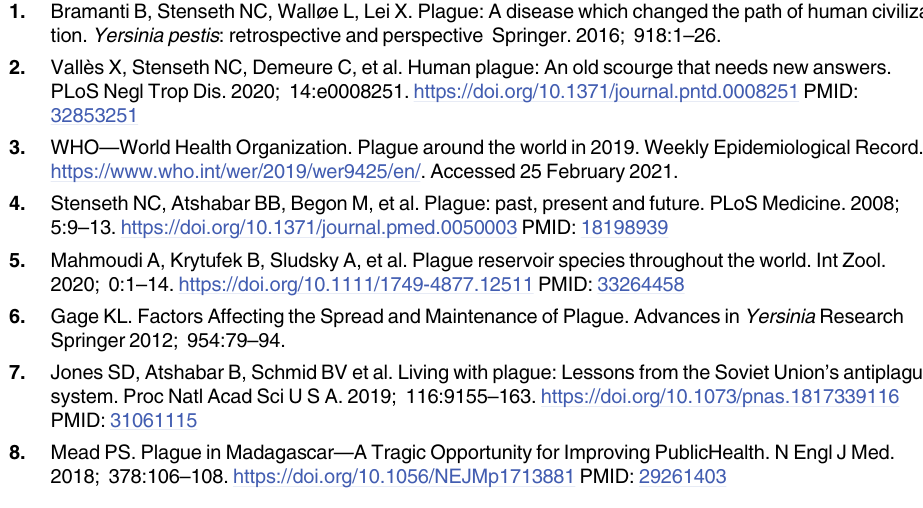
S2 Table. Epidemiological and laboratorial data from the 21 human cases of plague evalu- ated in the